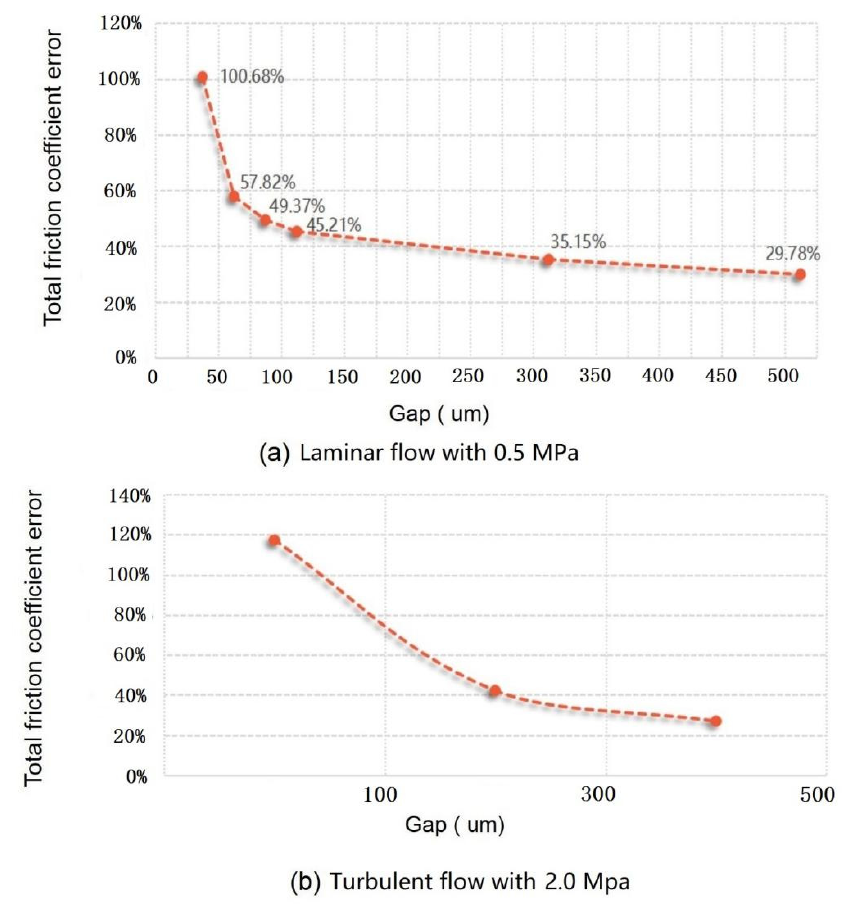
Figure 7. The total friction coefficient error of the sensor with a different gap in laminar flow ( a ) and in turbulent flow ( b ).